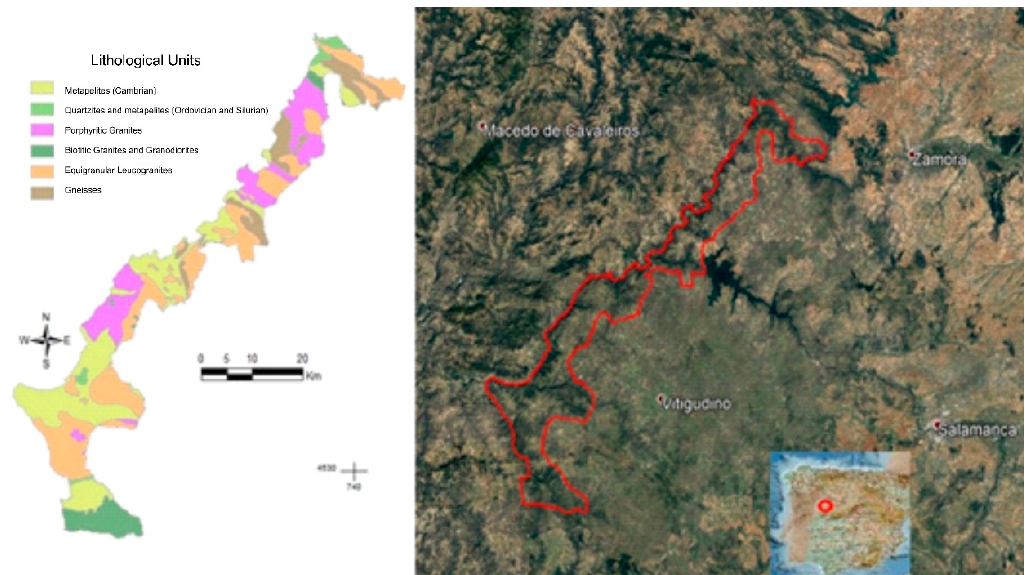
Figure 1. Geospatial distribution of the lithological units in the study area.